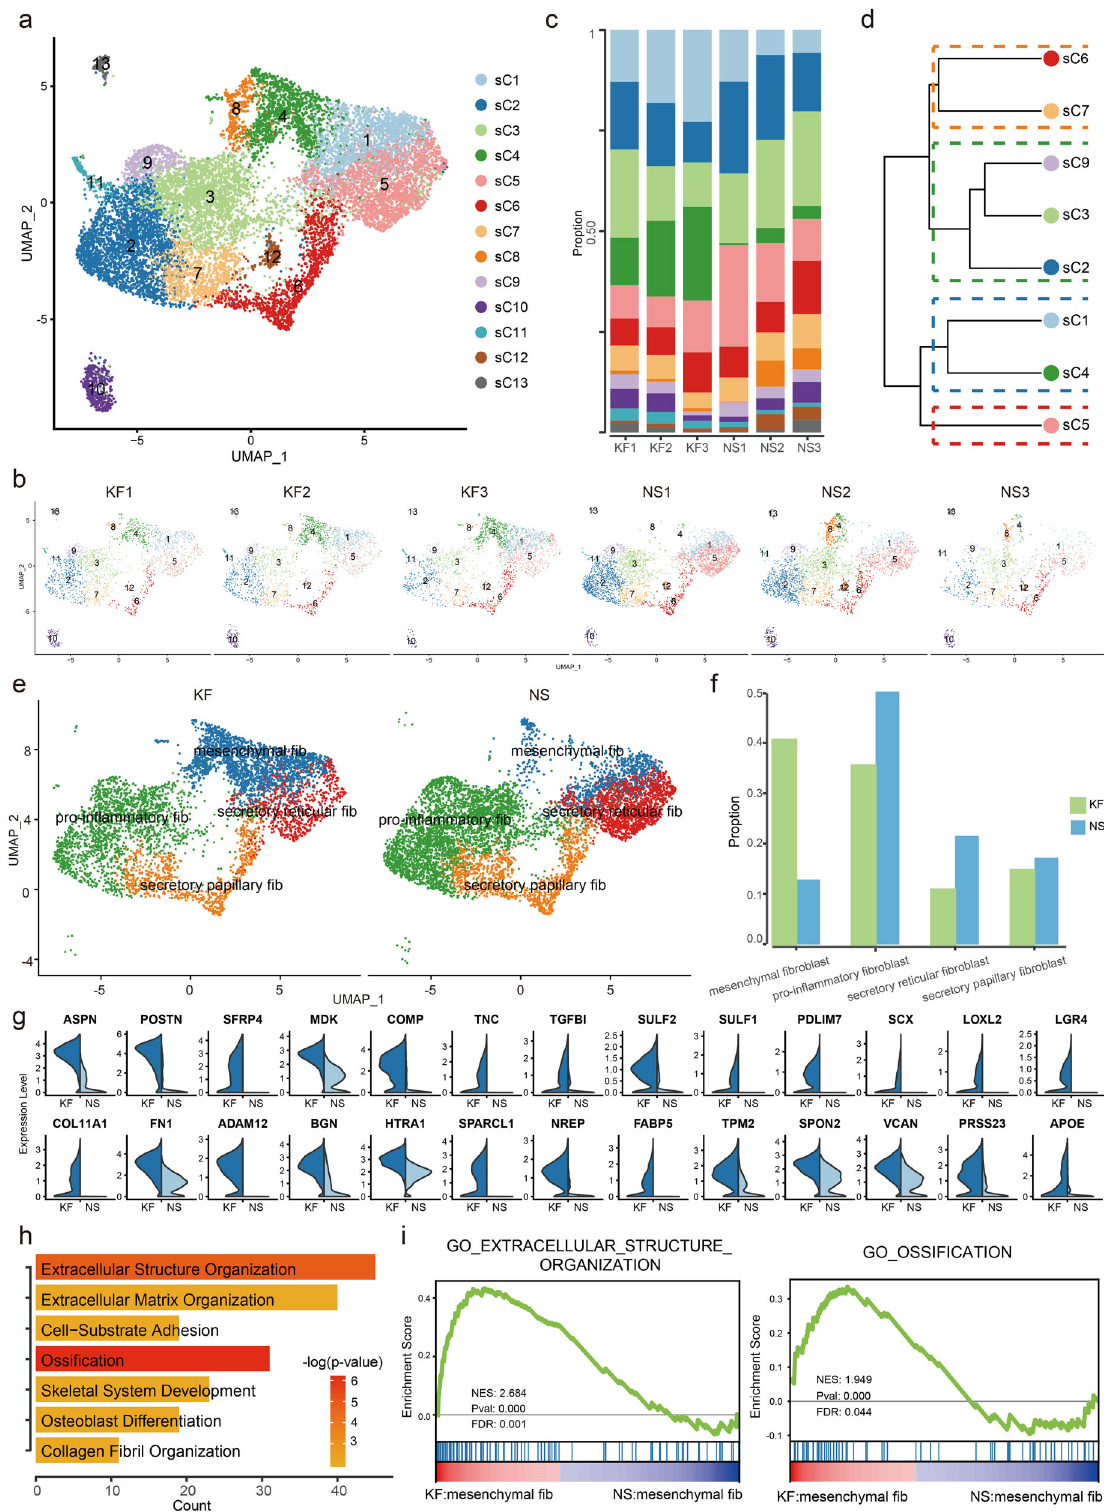
signaling, and POSTN signaling (Fig. 4c, left panel). Among them, TGF β 1 signaling was most signi fi cantly altered. The interactions between TGF β 1 and its receptors, TGF β R1 and TGF β R2, were markedly increased in keloid compared to normal scar (Fig. 4c, left panel). Notably, POSTN signaling was only altered in mesenchymal fi broblast subpopulations (Fig. 4c, left panel). In addition, we explored alterations in ligand signals